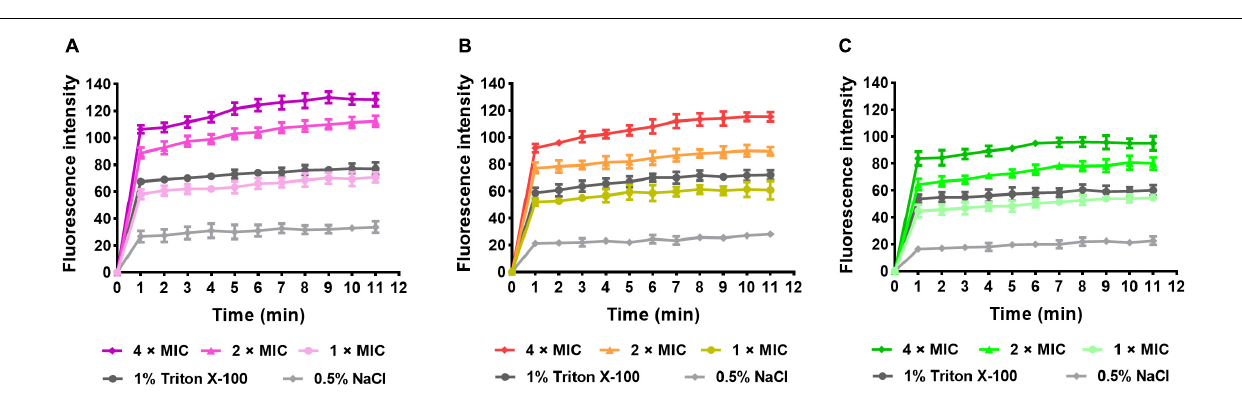
FIGURE 8 | NPN uptake assay. (A) E. coli (CMCC44103) was treated with S1, (B) E. coli (SYPB-3820) treated with S2, (C) S. aureus (CMCC26003) treated with